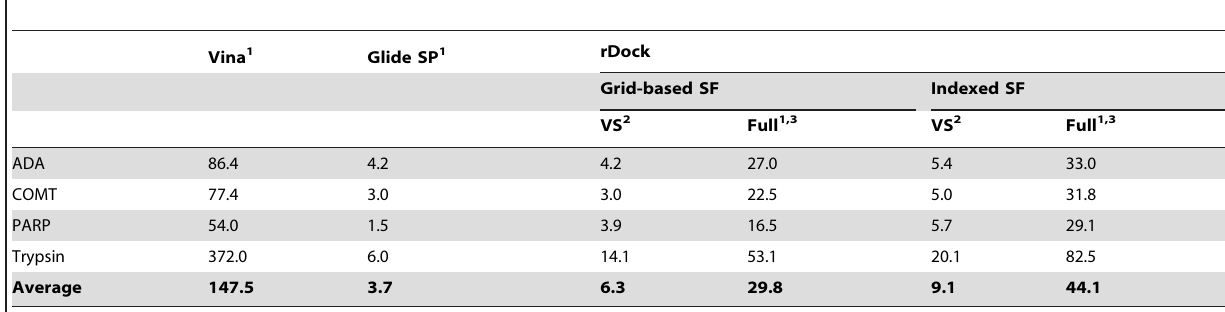
Table 4. Average computing times (in seconds per ligand) on 4 DUD